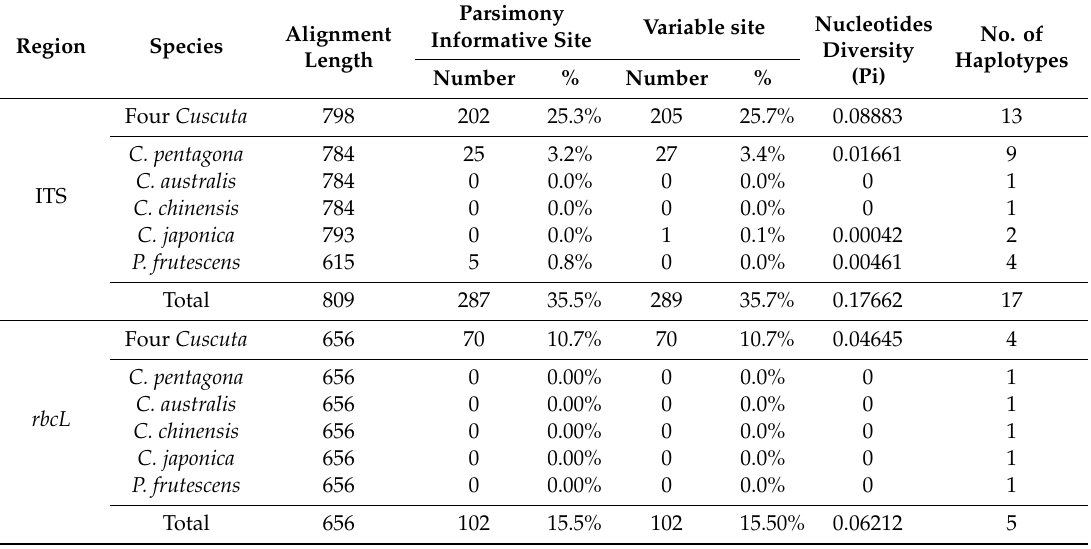
Table 4. Comparative analysis of DNA barcodes for four Cuscuta species and two Perilla frutescens .